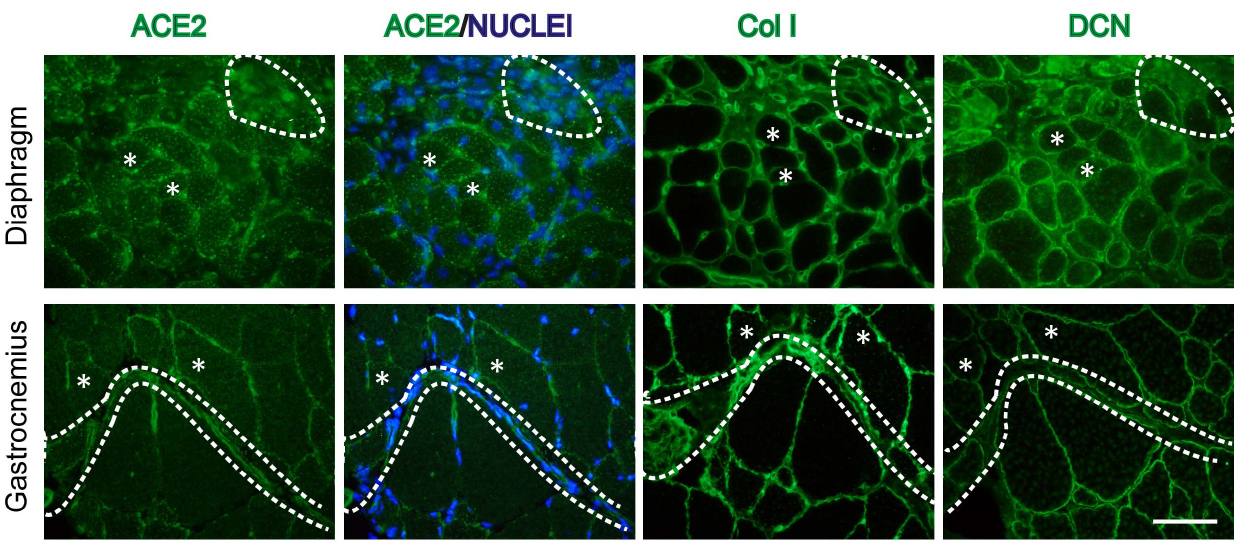
Figure 3. ACE2 localizes at the sarcolemma and interstitial space in dystrophic skeletal muscle. Immunostaining of ACE2, collagen I (ColI), and decorin (DCN) in cryosections obtained from GAST and DIA of mdx . Nuclei were stained with Hoechst. The delimitated area shows the same fibrotic tissue zone in three serial sections of GAST and DIA mdx muscles, where ACE2 immunostaining is probably associated with interstitials cells. Asterisks show a single fiber, in which ACE2 immunostaining is mainly localized at the sarcolemma. Bar 50